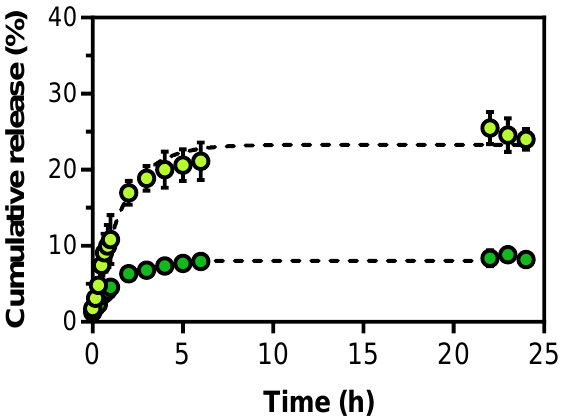
Figure 9. Cumulative DOX release profile from the LNLCs M3 at pH 5.5 (stimulated endosomal environment) (light green data) and pH 7.5 (stimulated physiological/plasma environment) (dark green data) as a function of time (25 h). The data are expressed as mean ± standard deviation of three independent measurements. The lines represent the best kinetic fit obtained according to the first-order model.